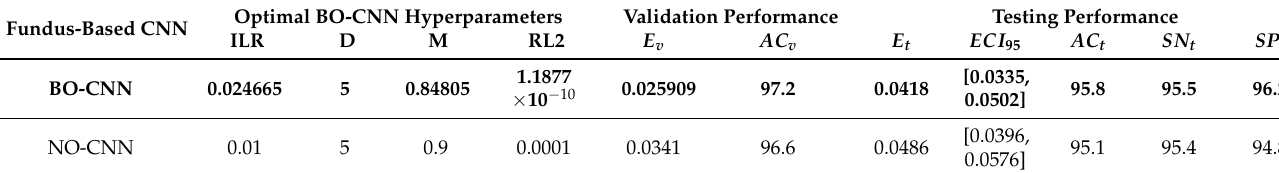
Table 5. Summary of the results obtained for the proposed BO-CNNs and NO-CNN trained using the OCT dataset in Experiment 2. The accuracy, sensitivity, and specificity are expressed as percentages. Entries of the CNN achieving the best performance are written in bold